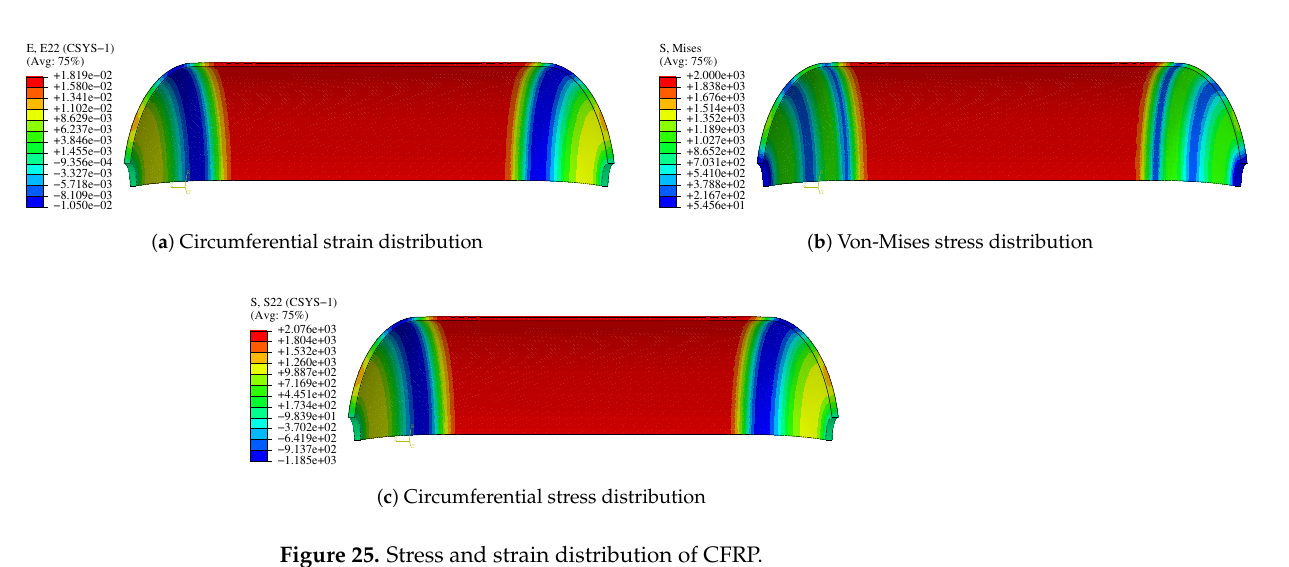
Figure 24. Stress and strain distribution of liner.